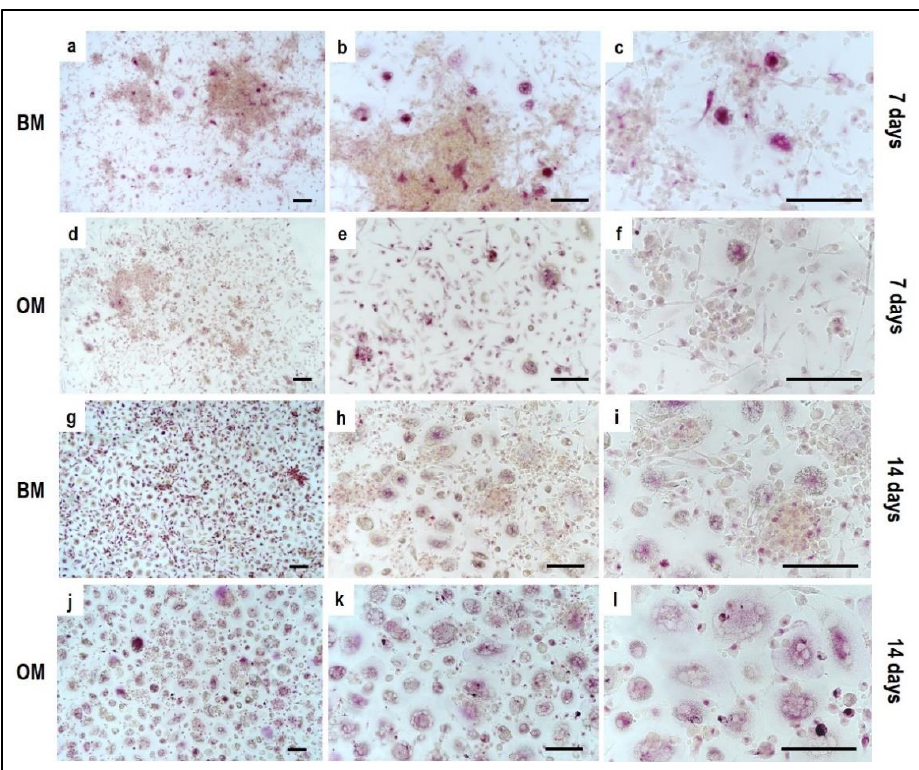
Figure 8. Microphotographs of Tartrate-Resistant Acid Phosphatase (TRAP) staining of PBMCs derived from the indirect co-culture in basal medium (BM) and osteogenic medium (OM) at 7 days and 14 days; ( a – c ): basal medium at 7 days, ( d – f ): osteogenic medium at 7 days, ( g – i ): basal medium at 14 days, ( j – l ): osteogenic medium at 14 days. Scale bar: 100 µm.